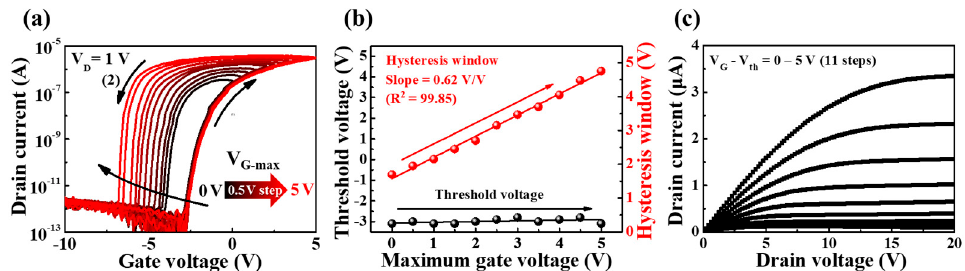
Figure 3. ( a ) Transfer characteristic (I D – V G ) curves as a function of maximum gate voltage (0 to 5 V in 0.5 V steps) at constant V D = 1 V in double sweep mode. ( b ) Hysteresis window and threshold voltage extracted from transfer curves in double sweep mode. ( c ) Output characteristic (I D –V D ) curves measured at V G – V th from 0 to 5 V at 0.5 V increments.